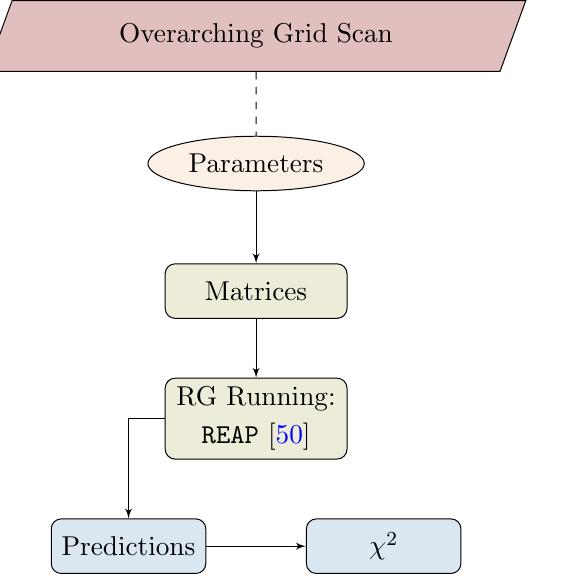
Figure 1 . Parameter scan and data (cid:13)ow for a single point. (cid:31) 2 denotes calculation of the goodness- of-(cid:12)t test against experimental